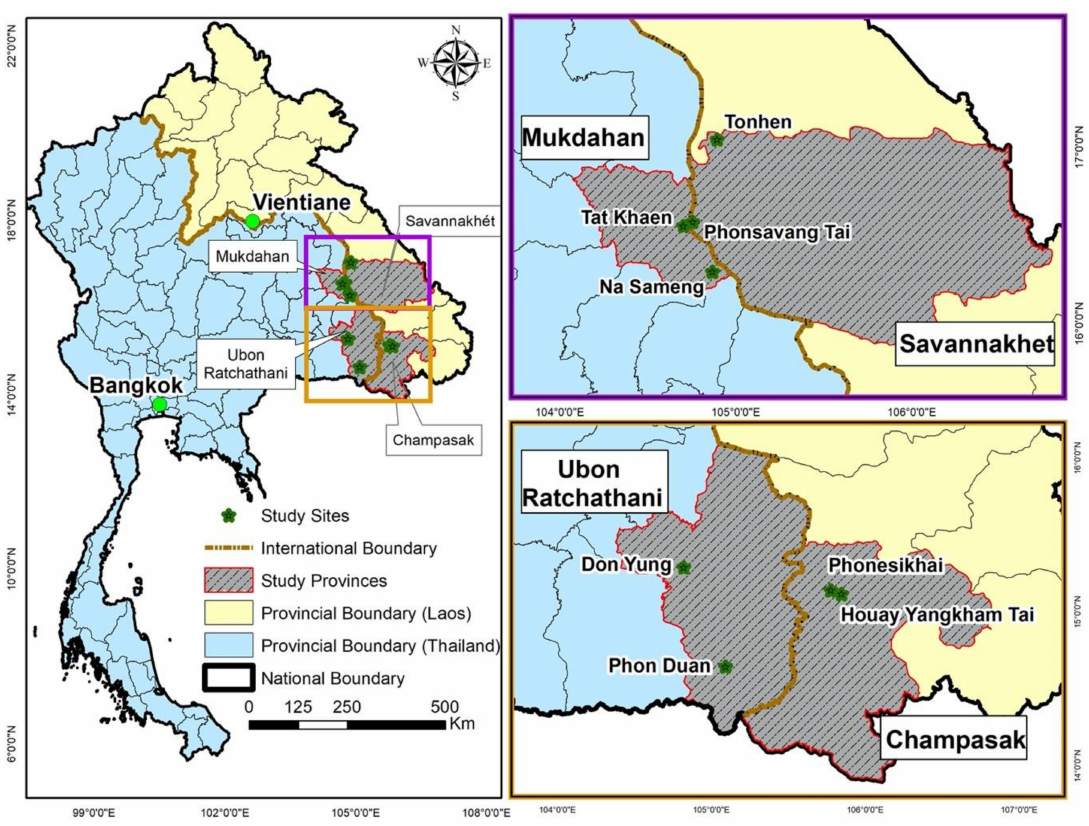
Figure 1. Study sites in Laos and